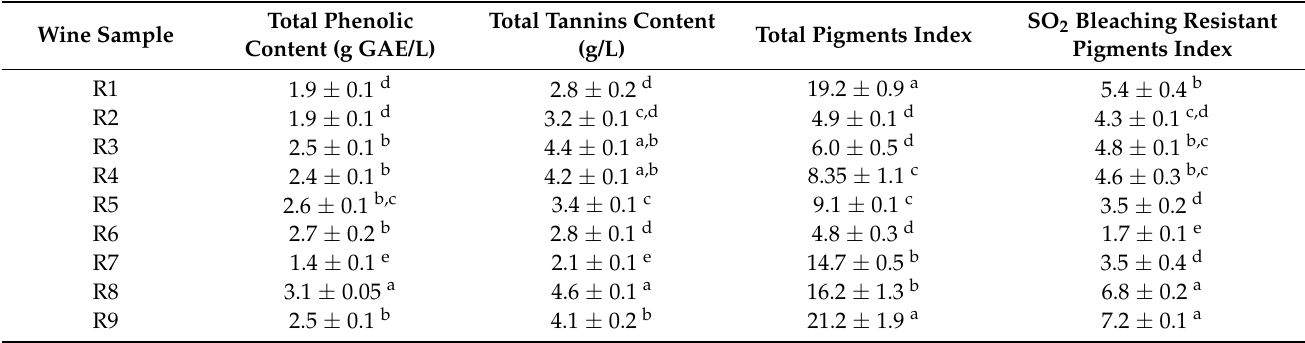
Table 1. Phenolic characterization of the different red wines. Values represent means of triplicate determination ± SD. GAE: gallic acid equivalent. Different letters indicate the significant differences between samples in one column according to Tukey’s test, p <